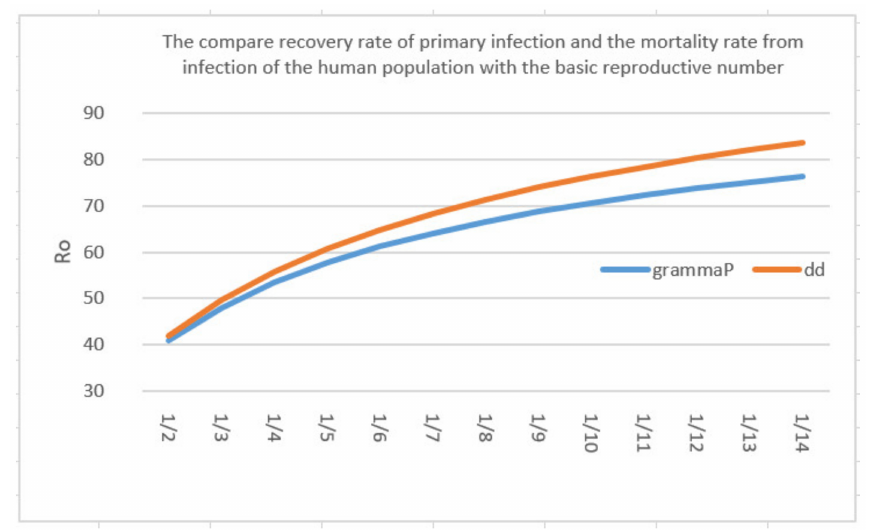
Figure 9. A comparison of parameters between d d and γ P with R 0 .